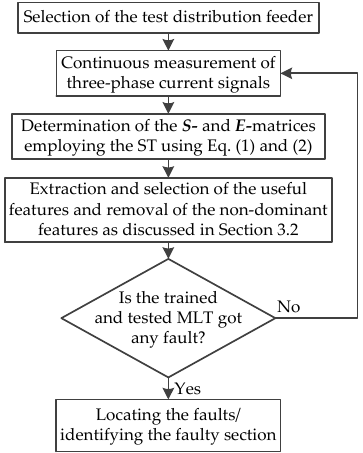
Figure 2. Fault location/faulty section identification flowchart employing the ST based MLT approach.